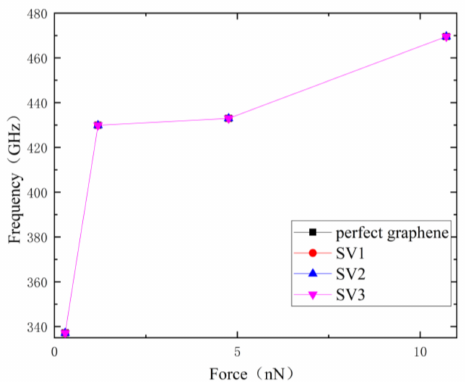
Figure 5. Resonant frequency variation curve of three graphene nanoribbons with different exter- nal